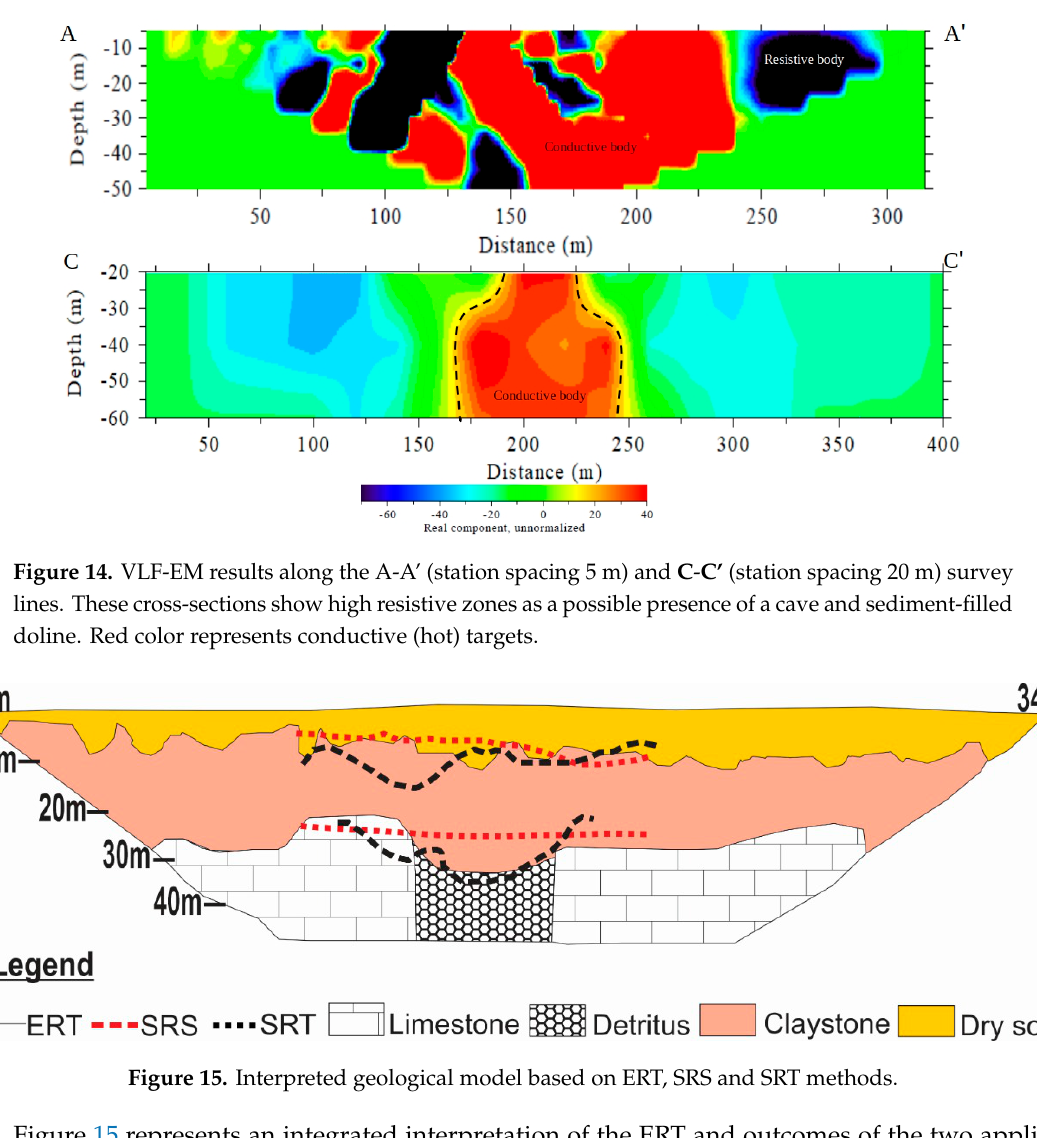
Figure 15. Interpreted geological model based on ERT, SRS and SRT methods.